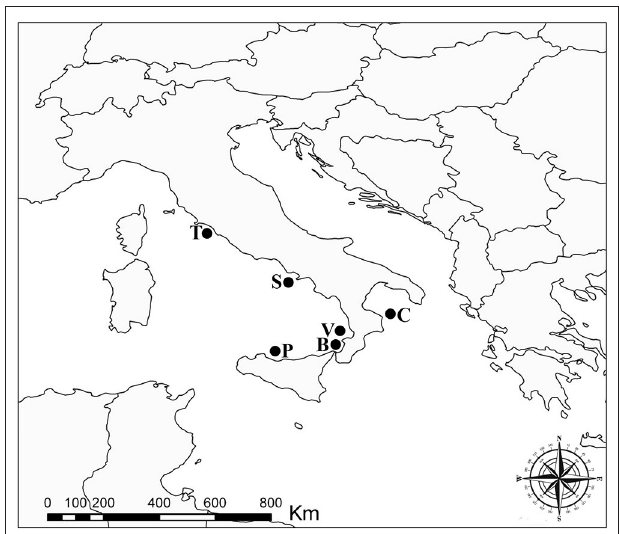
FIGURE 1 | Sampling localities of the Atlantic pomfret in the Mediterranean Sea, 2021–2022. B, Bagnara Calabra; C, Cariati; P, Gulf of Palermo; S, Sorrento; T, Saline di Tarquinia; V, Vibo Valentia.